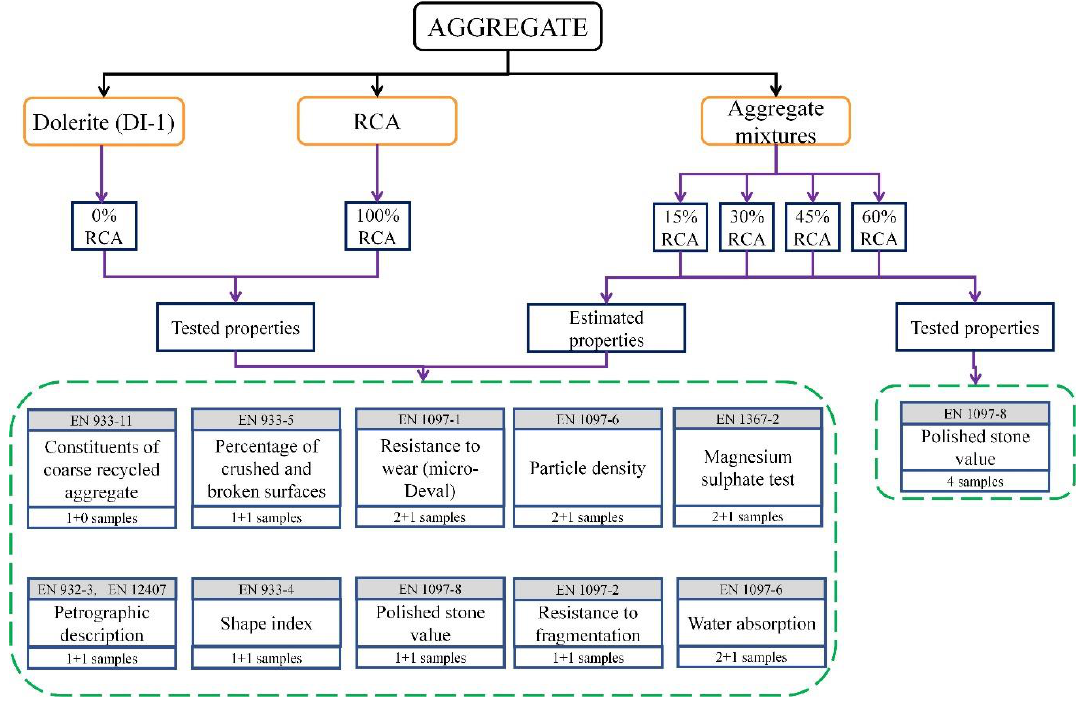
Figure 2. Types of aggregate, test methods and the number of test samples (RCA + DI-1) used in the study.